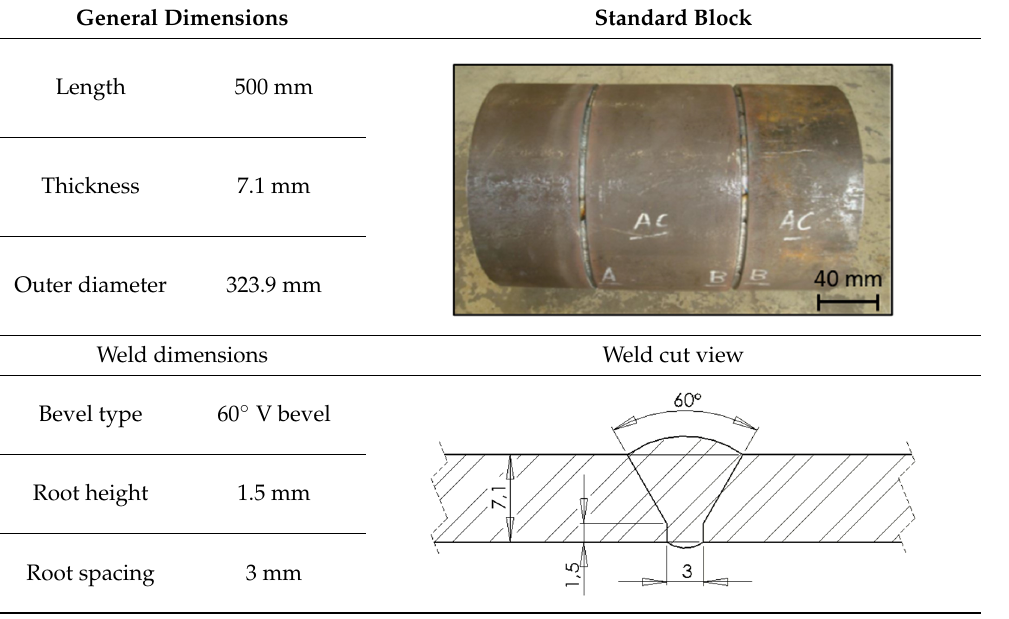
Table 1. Standard block specifications.